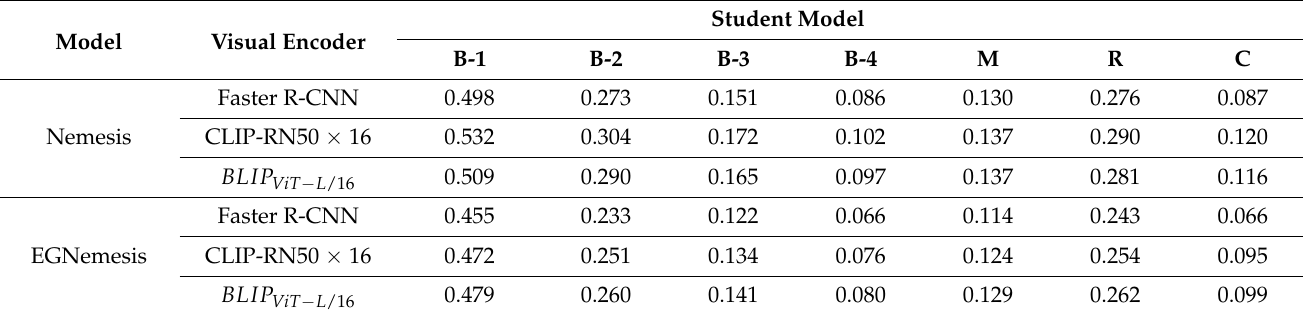
Table 2. Performance of the student model utilizing different visual encoders for both the Nemesis and EGNemesis models. (B: BLEU, M: METEOR, R: ROUGE, C: